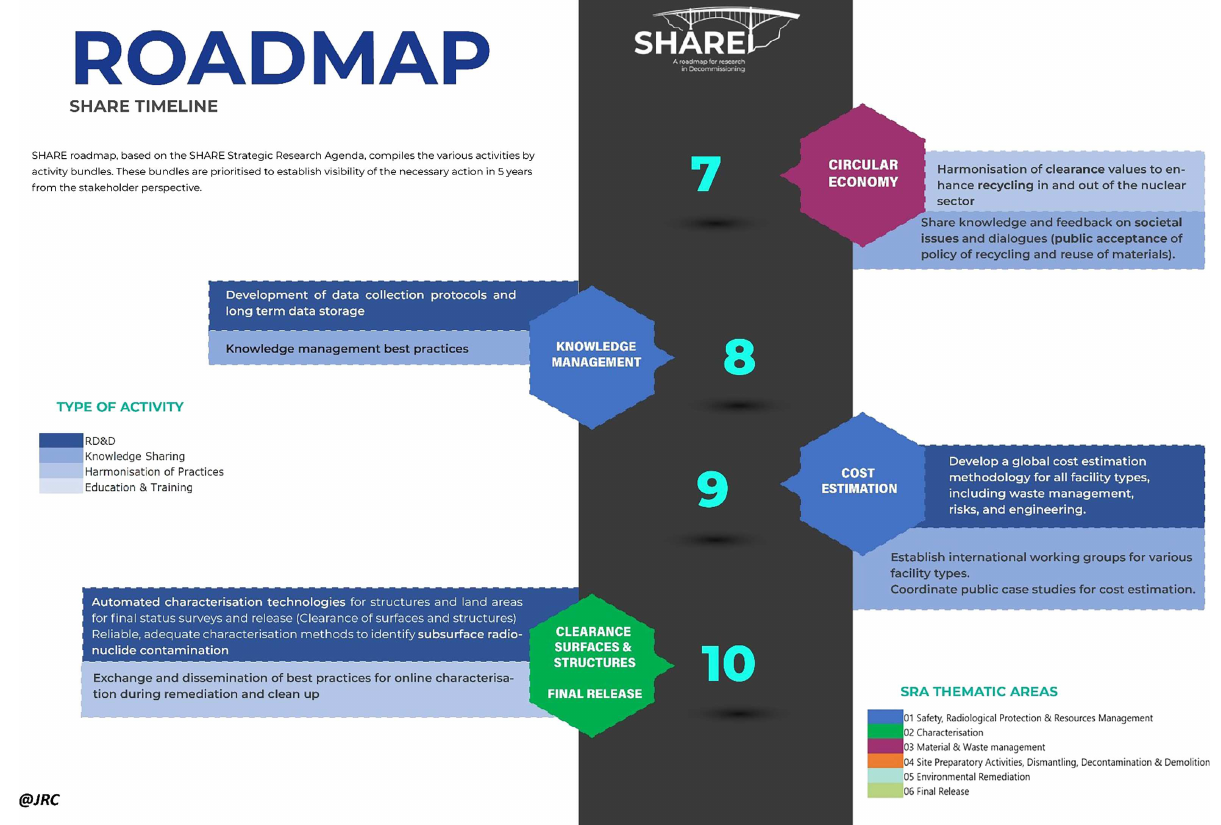
Fig. 11. SHARE Roadmap part